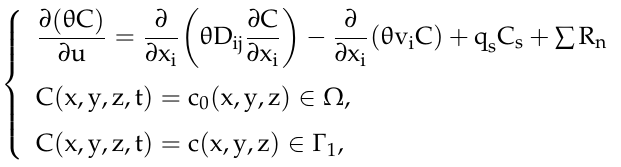
Figure 10. Fitting effect of the simulated water level and the measured water level.